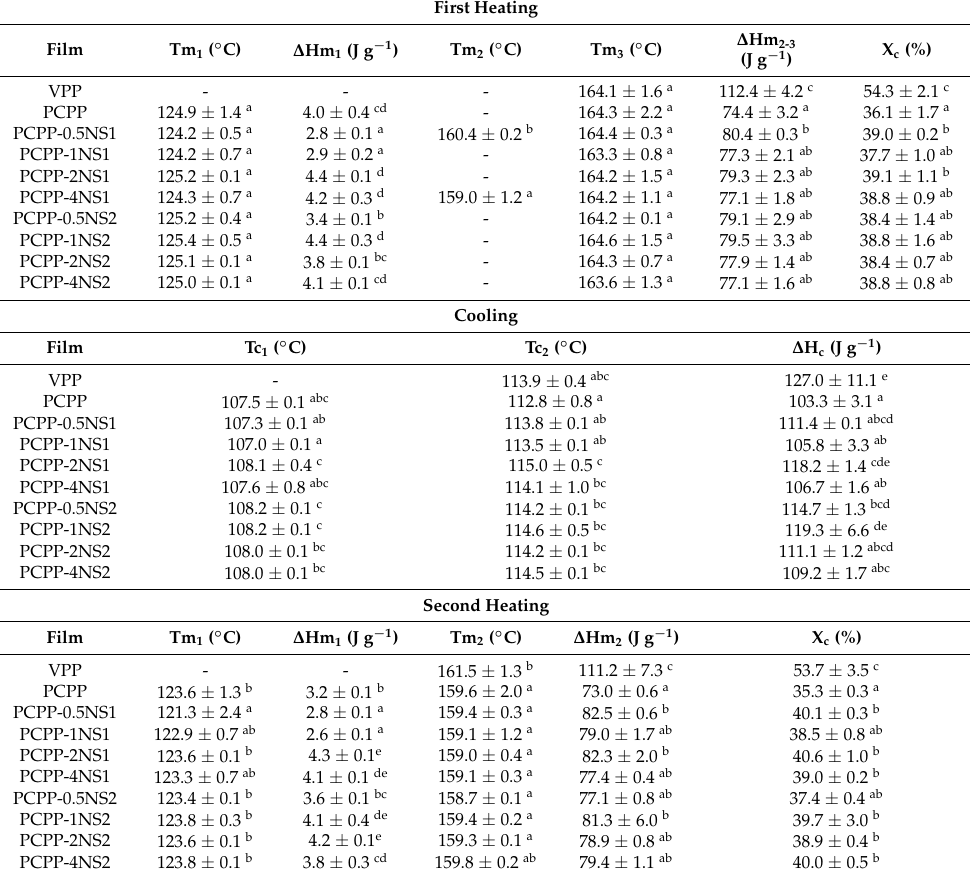
Table 2. DSC parameters of the control films and the developed